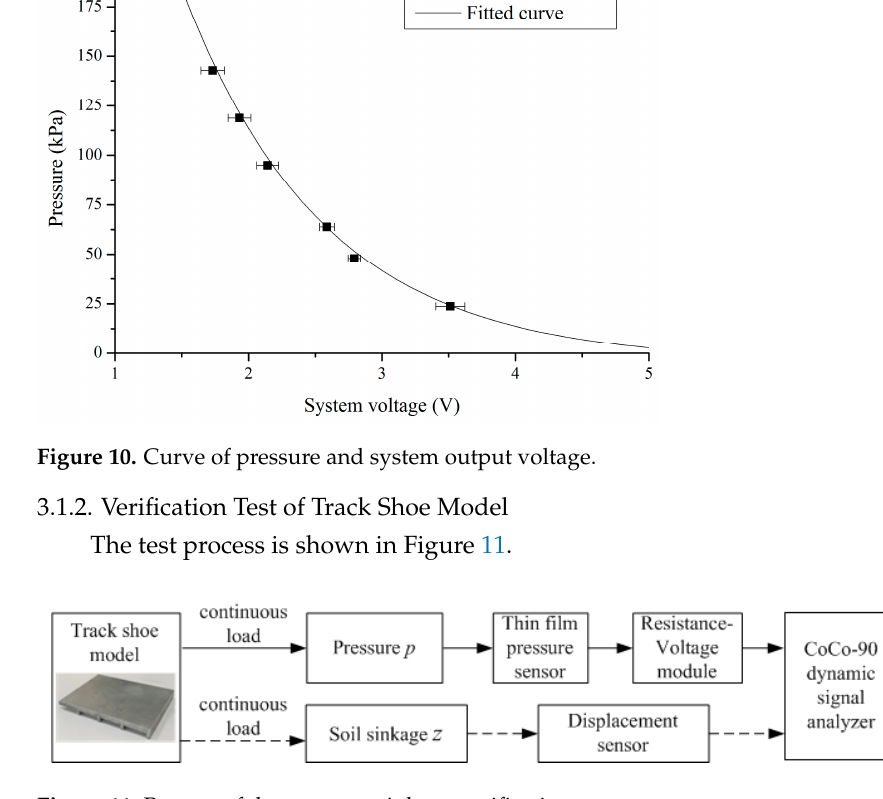
Figure 11. Process of the pressure-sinkage verification test. Figure 10. Curve of pressure and system output voltage.